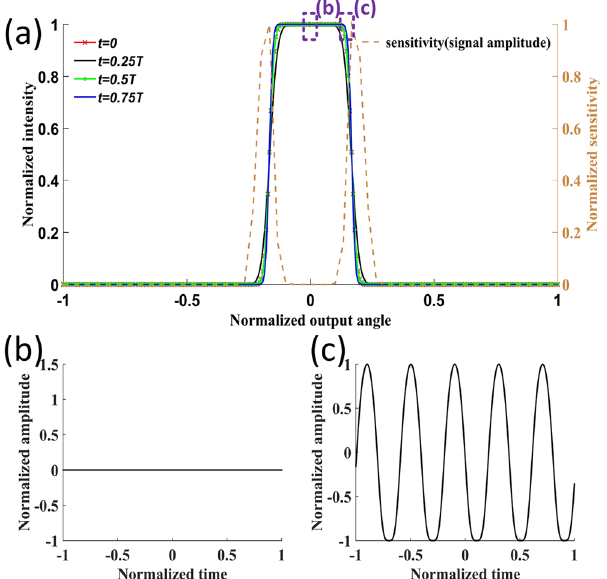
Figure 3. Simulation results of the sensitivity dependence of a large core fiber vibration sensor on the intensity profile when a top hat intensity profile was launched at the input. ( a ) shows the angular intensity profile at the MMF output when the coupling coefficient in Equation (1) was D = D 0 (1 + A m sin(2 π t / T )) 2 at 0, 0.25 T , 0.50 T , 0.75 T . A 0.01 size window was used to scan the angular distribution and to obtain the signal response. The amplitude of the signal response was used as the sensitivity, shown as the brown dashed curve. Two representative signal patterns detected by the windows are given in ( b ) at the center of the output and ( c ) at the edge of the intensity cliff. The difference between Fig. 3 and Fig. 1 is that different intensity profiles were launched at the fiber input, i.e. top hat in Fig. 3 and Gaussian in Fig. 1. A comparison between Fig. 3 and Fig. 1 suggests that the sensitivity depends on the intensity profile. For the top hat intensity profile, the sensitivity